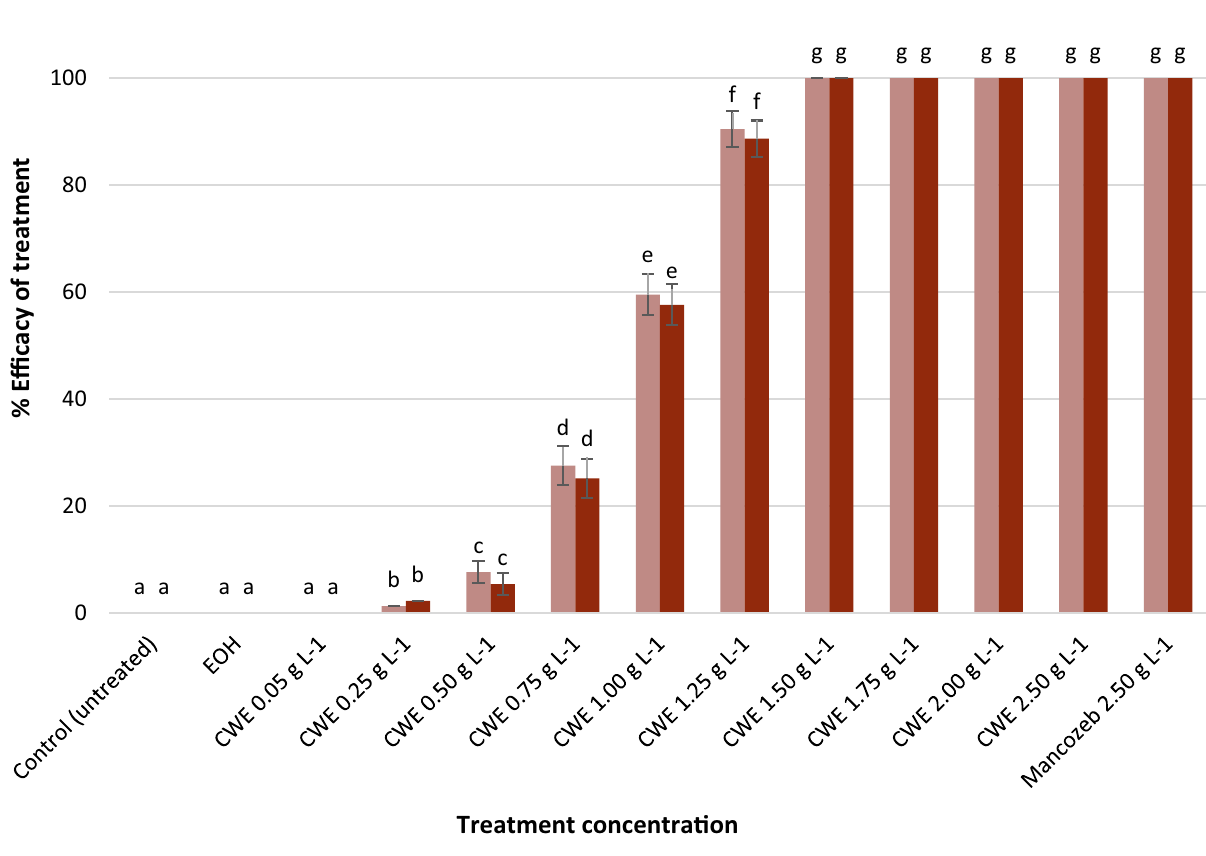
Figure 3. The efficacy of CWE on spore germination of C. musae. Trials 1 and 2 are shown by the light and dark bars, respectively. Based on the Tukey test, values followed by similar letters are not statistically different.